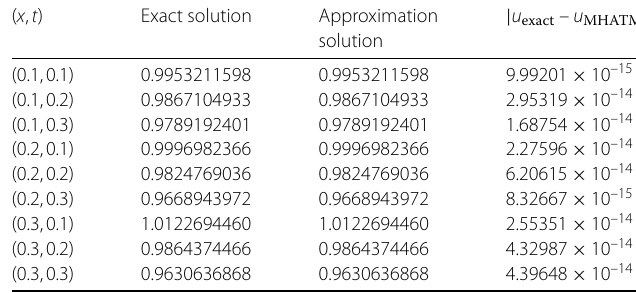
Table 1 E 7 in the solution of TFCRDEs using HATM for λ = 1